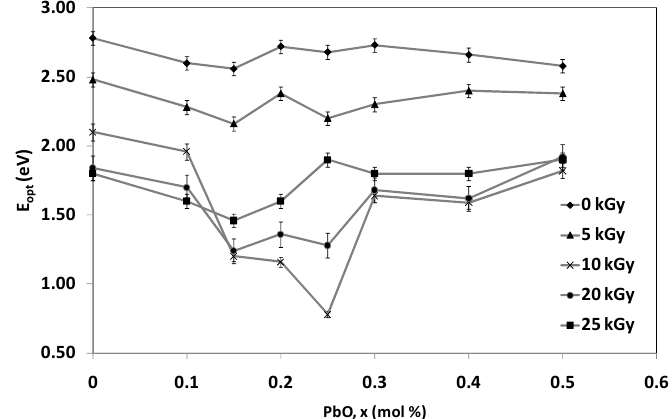
Figure 7. Variation optical band gap, E indirect transition with x = 0%–0.5% mol; y = 0.7% mol at various irradiation exposure. The lines represent the